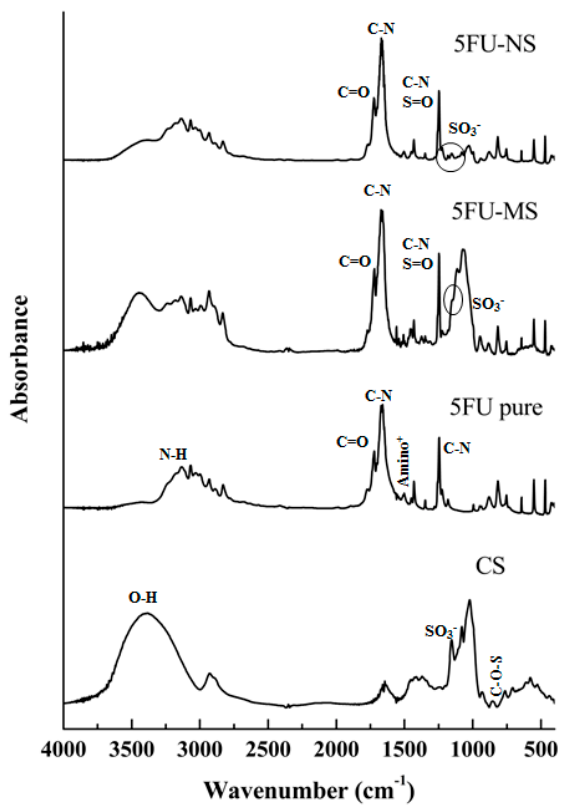
Figure 3. FTIR spectroscopy spectra of drug 5FU pure, chondroitin sulfate, and dry formulations, 5FU-MS and 5FU-NS.